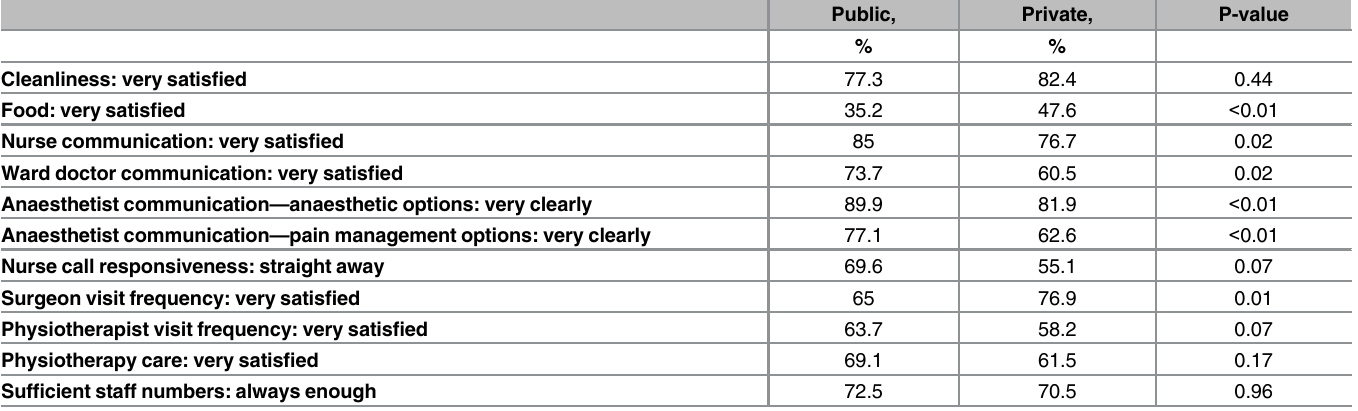
Table 6. Proportion per sector reporting the best (top)